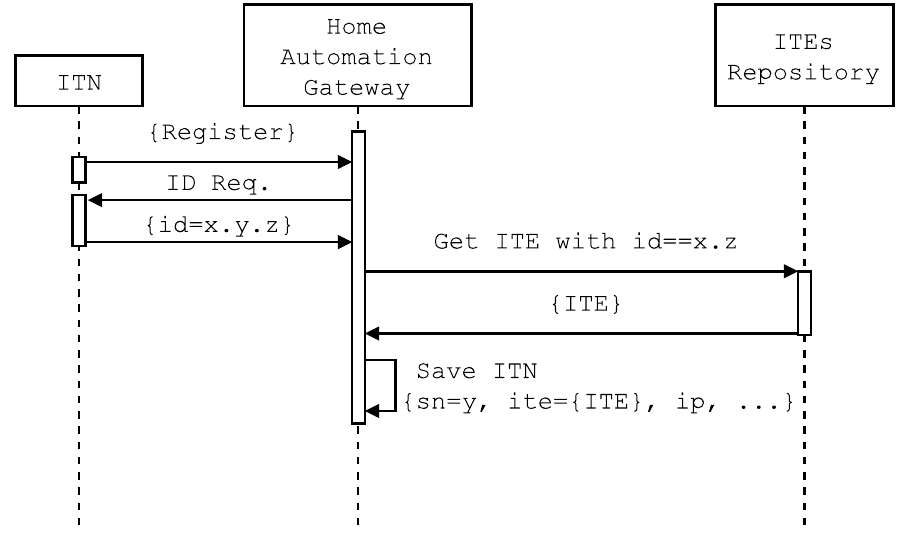
Figure 6. Self-registration protocol sequence